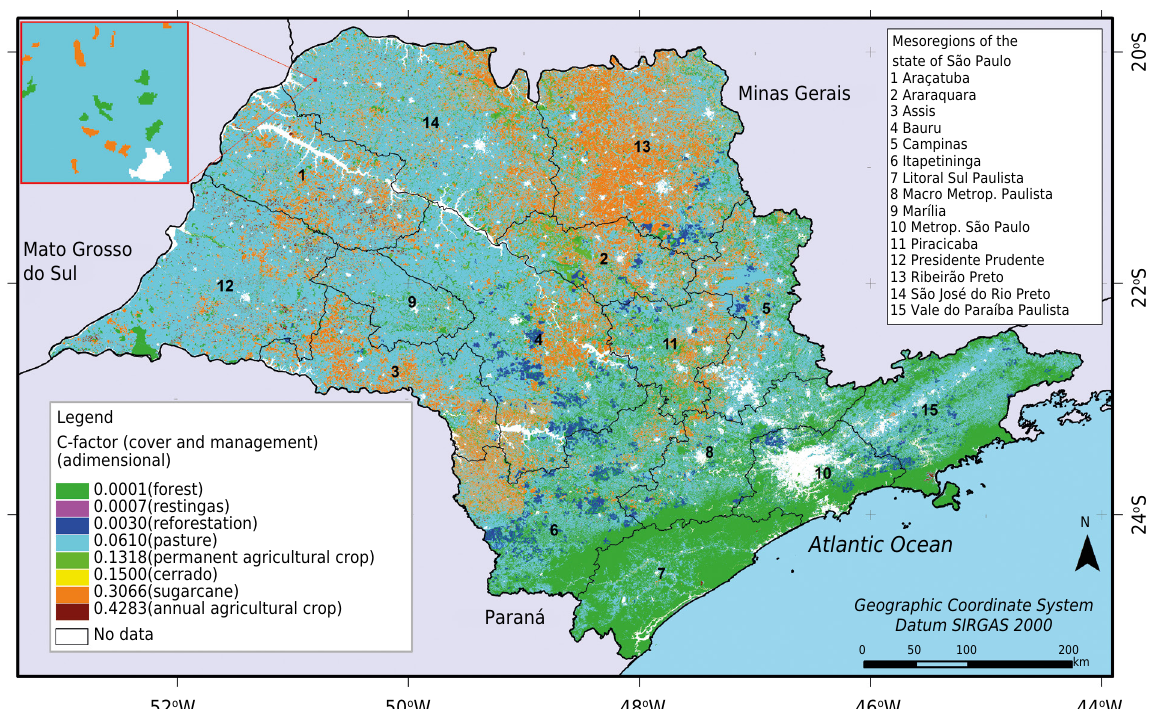
Figure 8. C-factor map of the state of São